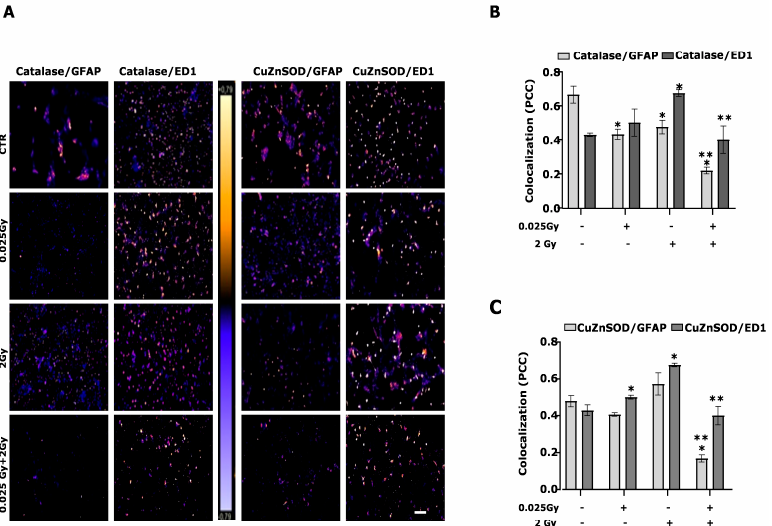
Figure 6. Expression of antioxidant enzymes in astrocytes and microglia. The expression of antiox- idant enzymes (catalase and CuZnSOD) and cell type markers (GFAP for astrocytes and ED1 for microglia) were estimated in retinal cell cultures irradiated by 2 Gy and/or 0.025 Gy 24 h after the last delivered dose, evaluating the colocalization of immunofluorescence markers. Colocalization of catalase/GFAP, catalase/ED1 or CuZnSOD/GFAP, and CuZnSOD/ED1 ( A ) were studied. The photomicrographs evidence the localization of fluorescence signals captured and processed using ImageJ software, (URL: https://imagej.nih.gov/ij/index.html, accessed on 9 July 2014) reproducing the images according to a scale of arbitrary colors where the signal strength is proportional to the colo- calization. Data are the mean ± SEM of n = 3 (250–300 cells per field/condition). Scale bar = 200 µ m. The bar graphs indicate the quantification of catalase (B) and CuZnSOD ( C ) colocalization with GFAP and ED1, as expressed by the Pearson correlation coefficient (PCC, * p < 0.0001 vs. CTR; ** p < 0.001 vs. 2 Gy, unpaired two-tailed Student’s t